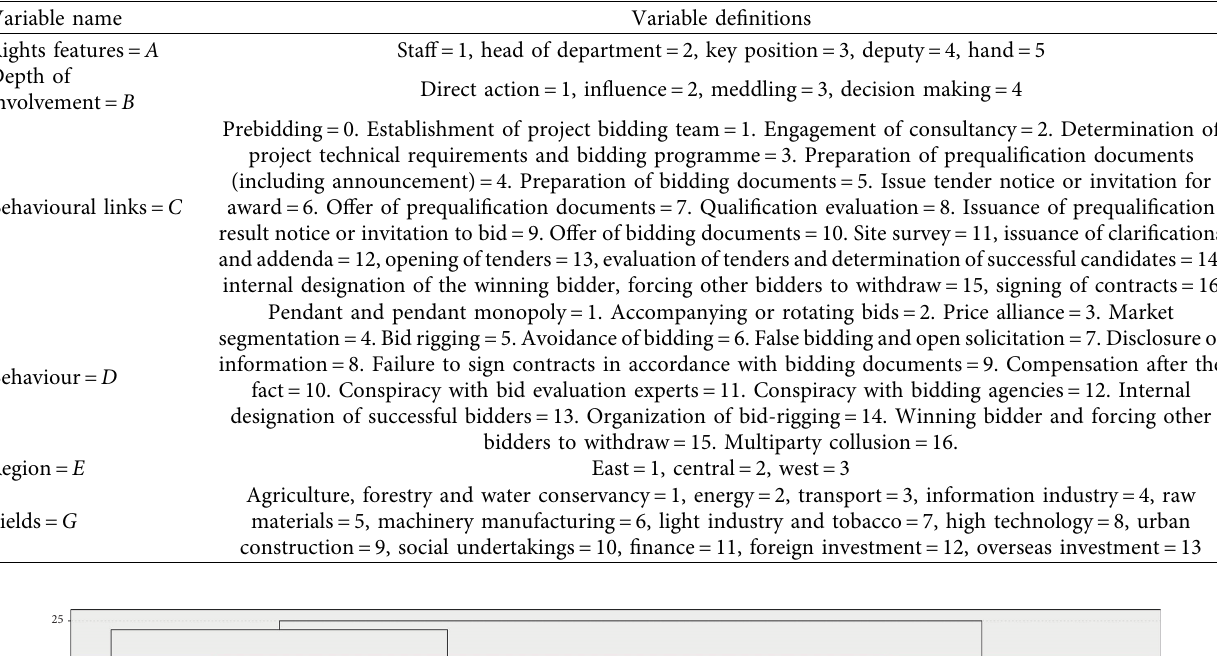
Table 1: Variable names and definitions.